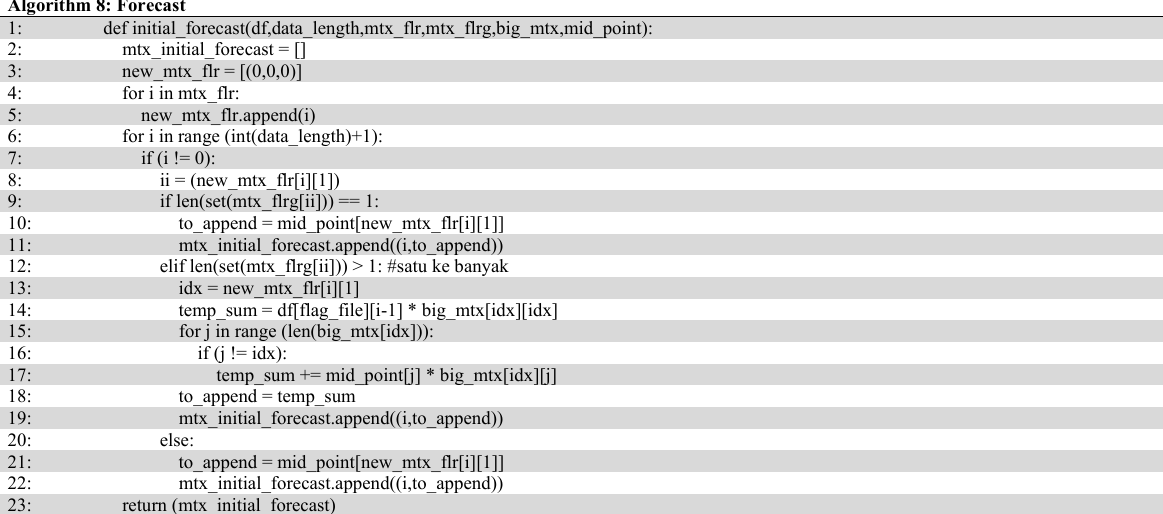
Algorithm 8: Forecast